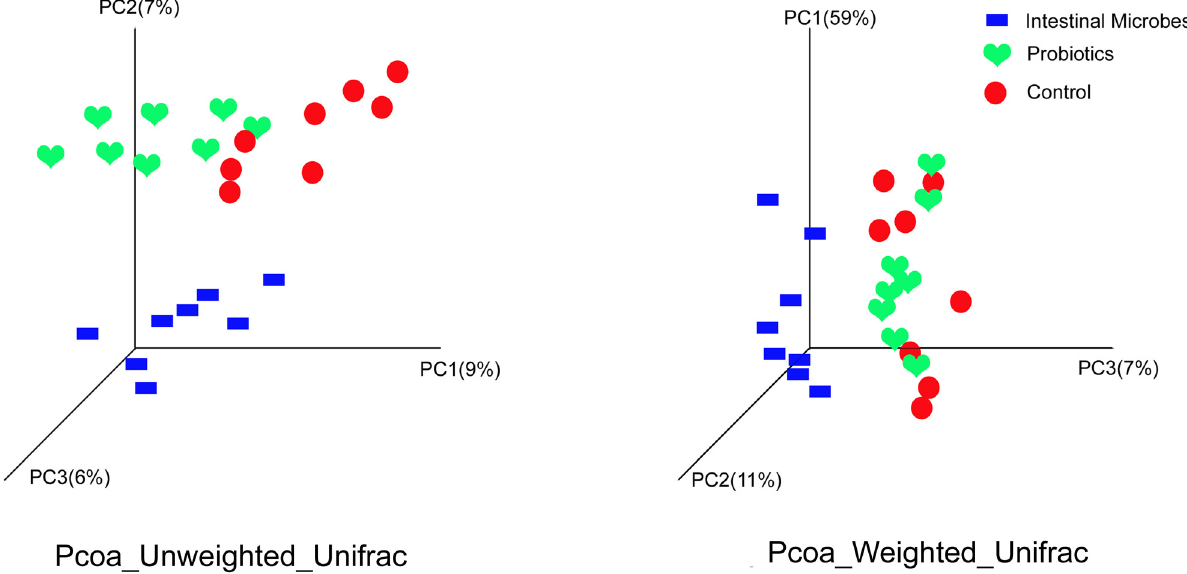
Fig 5. Principal coordinates analysis (PCoA) of unweighted and weighted UniFrac distances. These are for the fecal microbiota of the three experimental mice: control, probiotics, and intestinal microbes. Analysis was based on the Illumina bacterial 16S rRNA gene dataset (V4